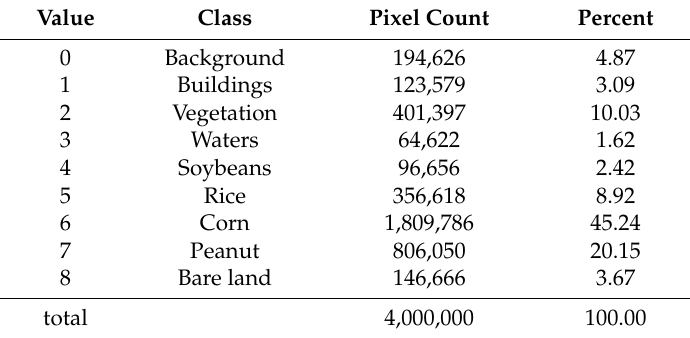
Figure 8. Samples and labels for network training. Table 5. The distribution of per class of the training samples.